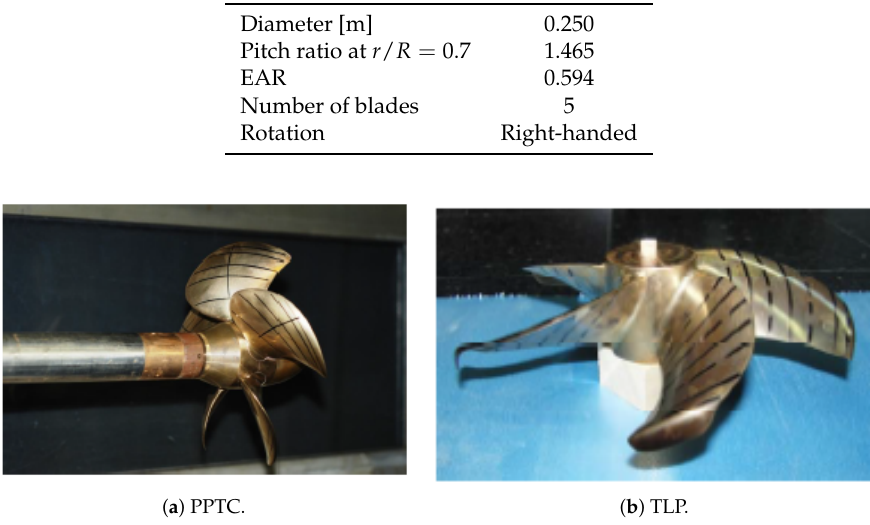
Table 2. Main geometric parameters of the tip loaded propeller (TLP) propeller.